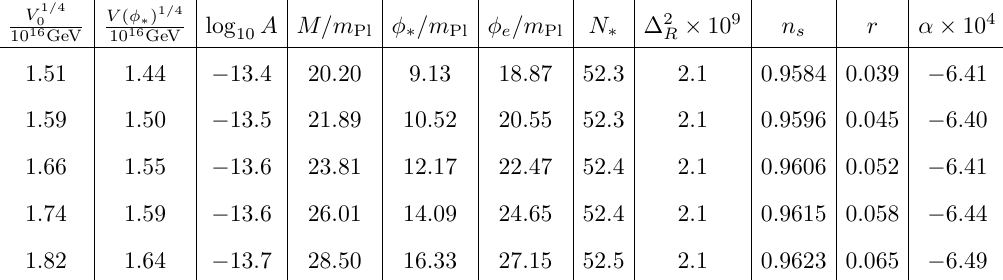
Table 6. Values of the parameters for successful inflation with a Coleman-Weinberg potential.